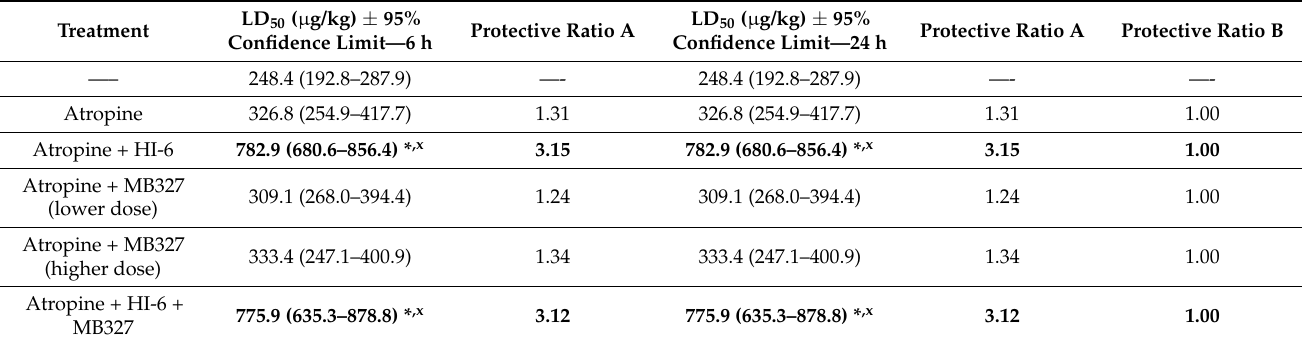
Table 4. The effect of experimental endpoint on the protection provided against the lethal effects of cyclosarin in